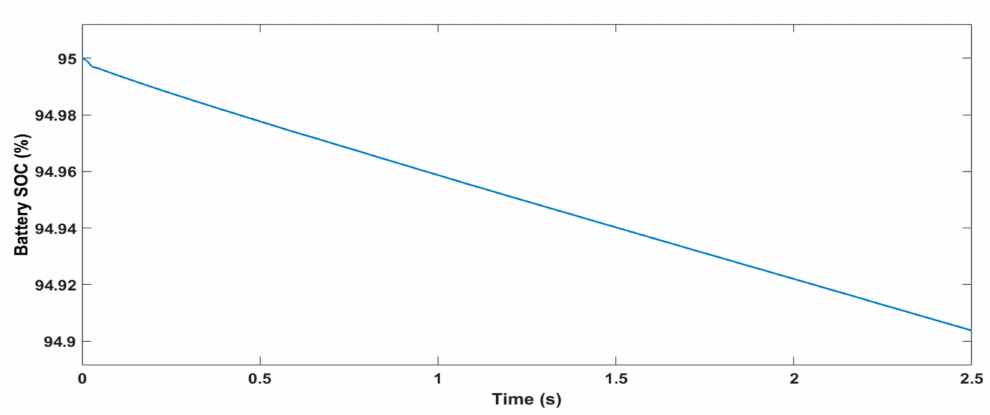
Figure 18. Discharging of battery at SOC 95%.